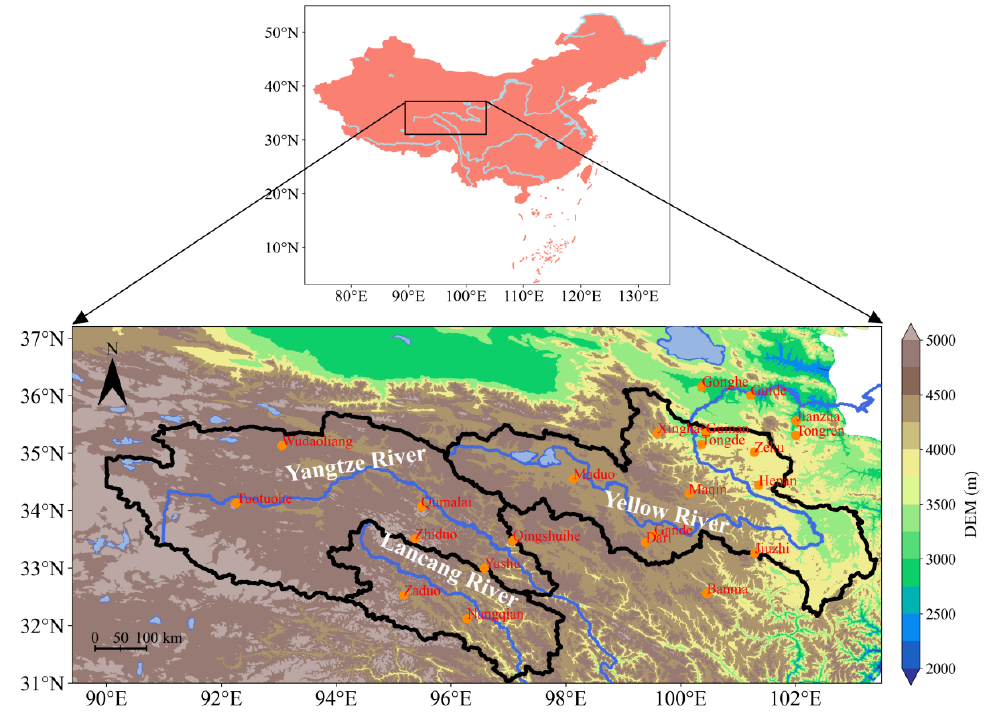
Figure 1. Three River Source Region and observation station.